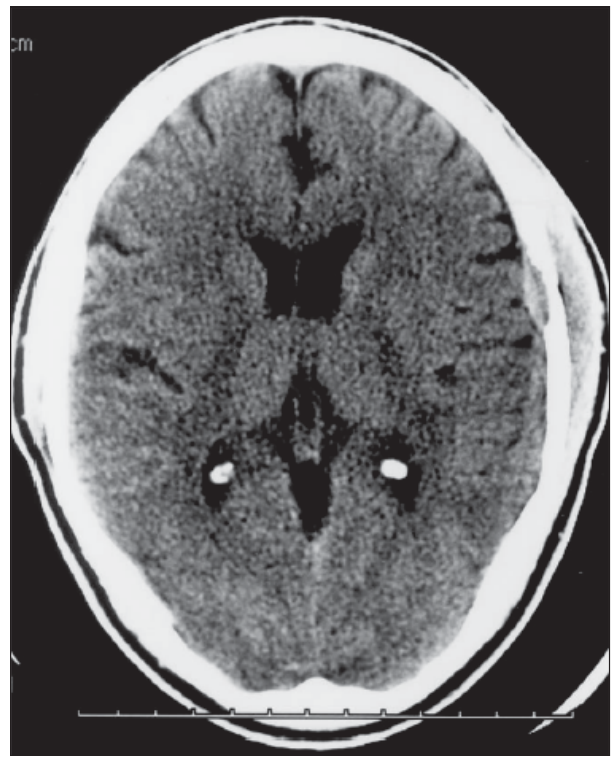
Figure 2) Nonaugmented computed tomography of the head. Destruc- tive changes in the left temporal bone with associated soft tissue swel